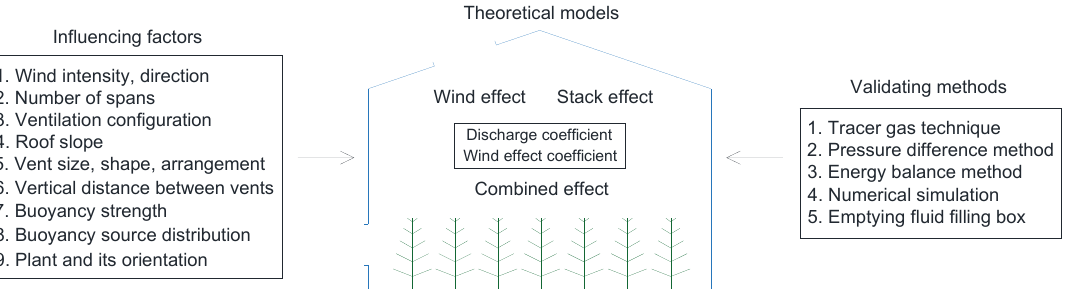
Figure 2. The factors involved in natural ventilation in greenhouses, considered from the past to present.